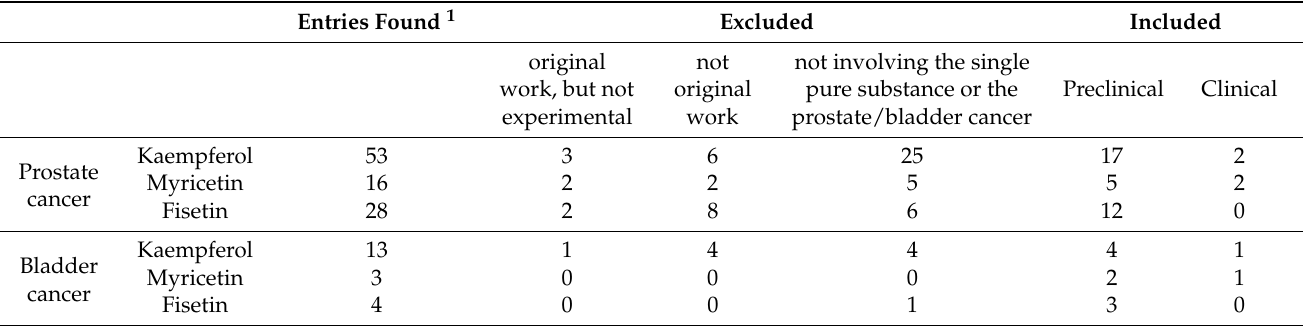
Table 1. Included and excluded